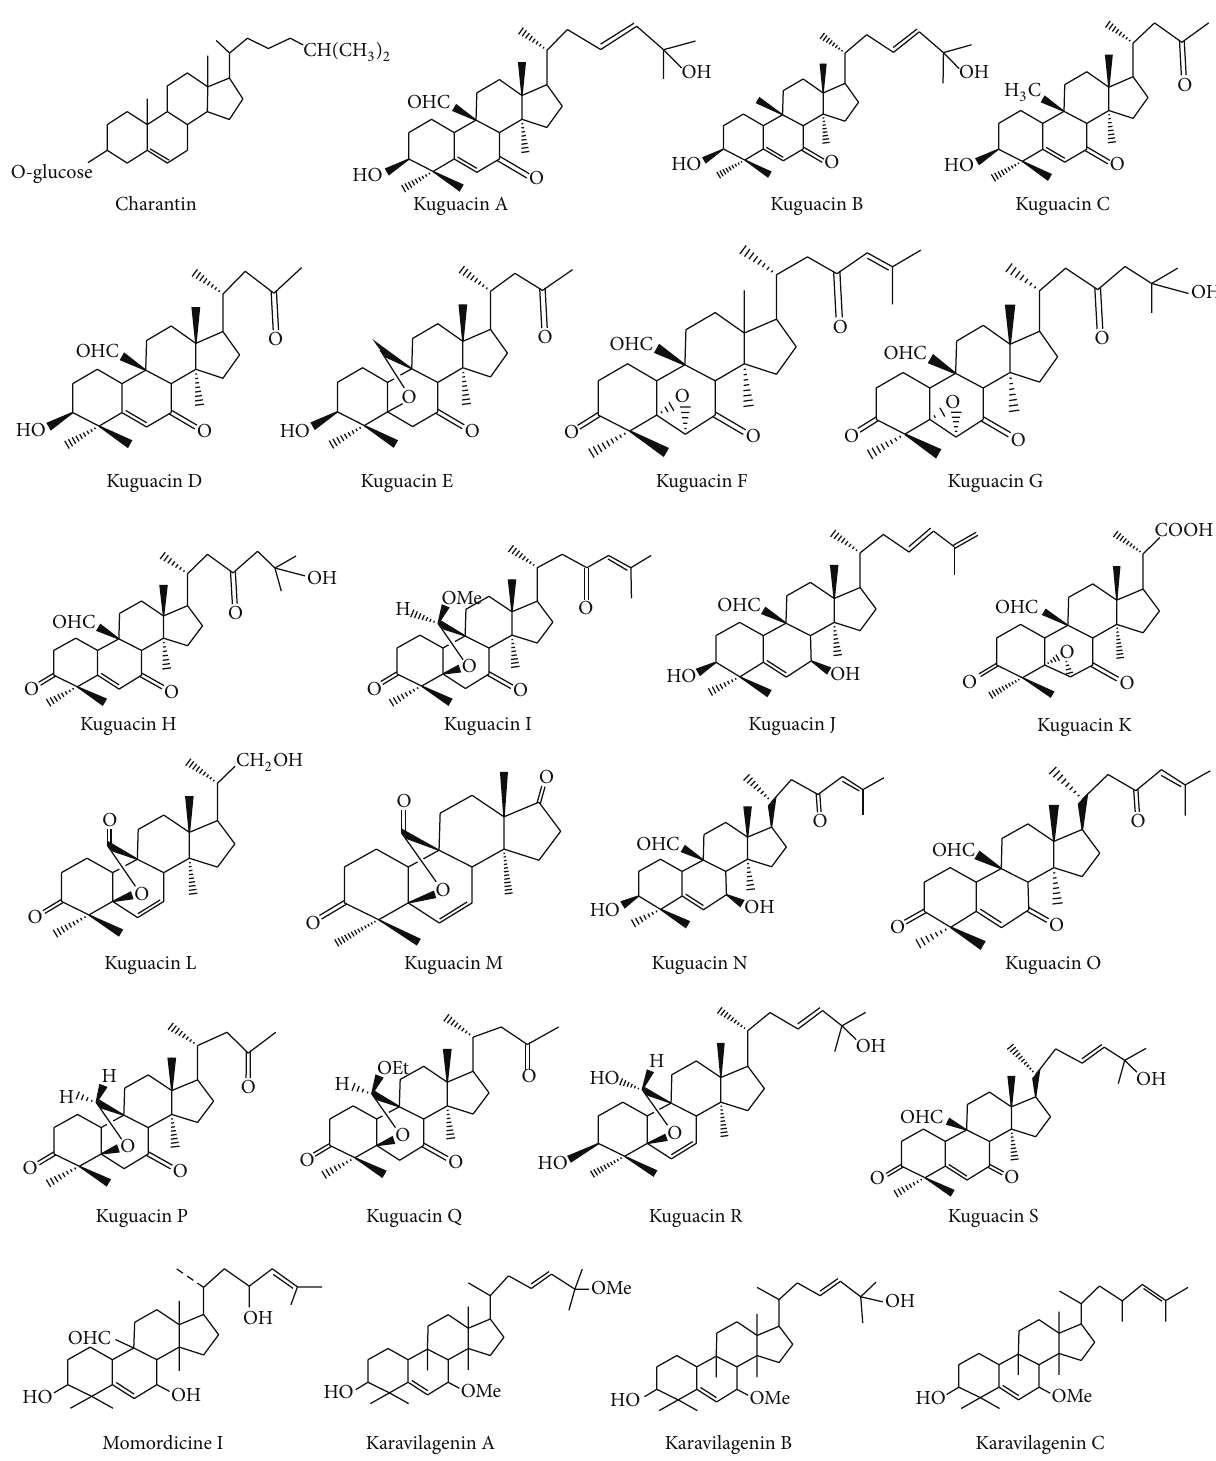
Figure 3: Chemical structure of some cucurbitane triterpenoids isolated from M. charantia .